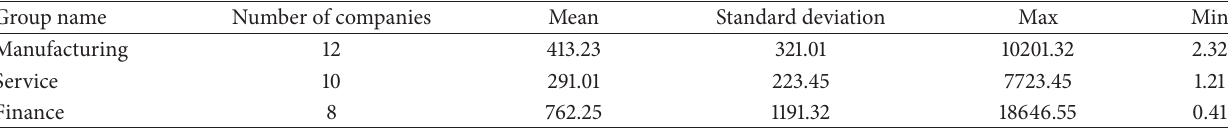
Table 1: Basic statistics of the data in each sector.